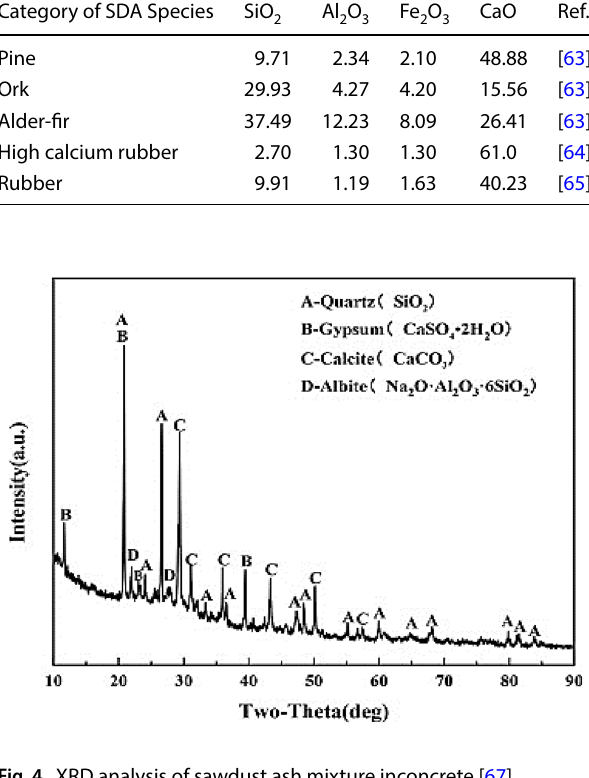
Fig. 4 XRD analysis of sawdust ash mixture inconcrete